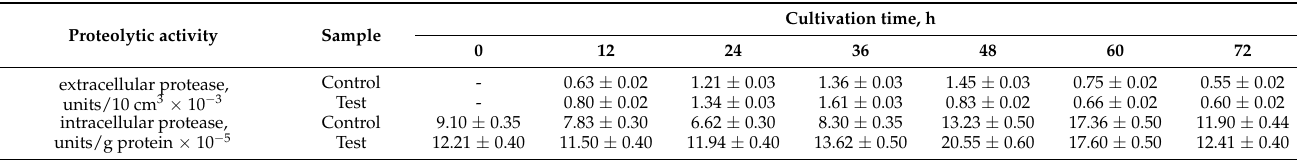
Table 3. Effect of combined treatment of yeast with ultrasound and a mix of Krebs cycle acids on protease